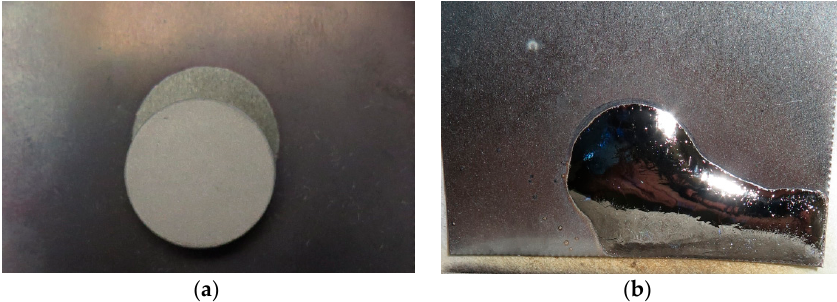
Figure 1. Titanium sample on molybdenum plate: ( a ) Small green compact prior to solar melting; ( b ) after solar melting during calibration tests.